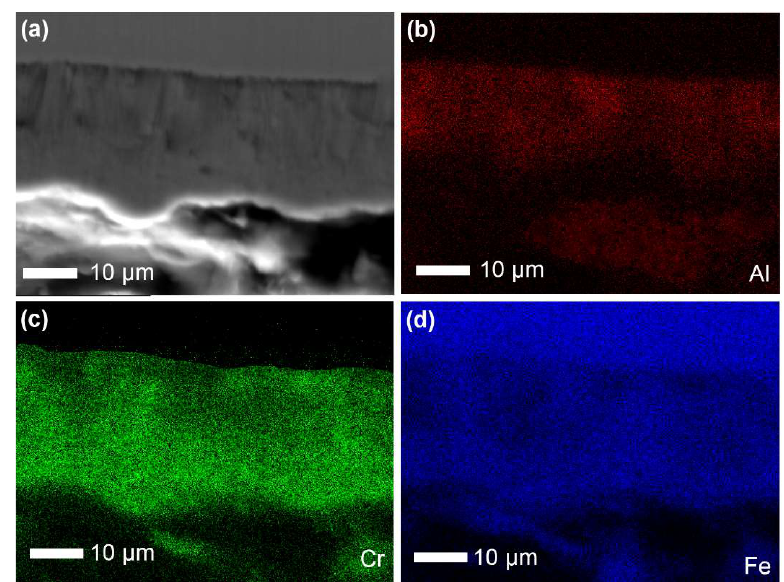
Figure 10. ( a ) SEM image of the Fe-Al-Cr coating, and EDS mapping of ( b ) Al, ( c ) Cr, and ( d )